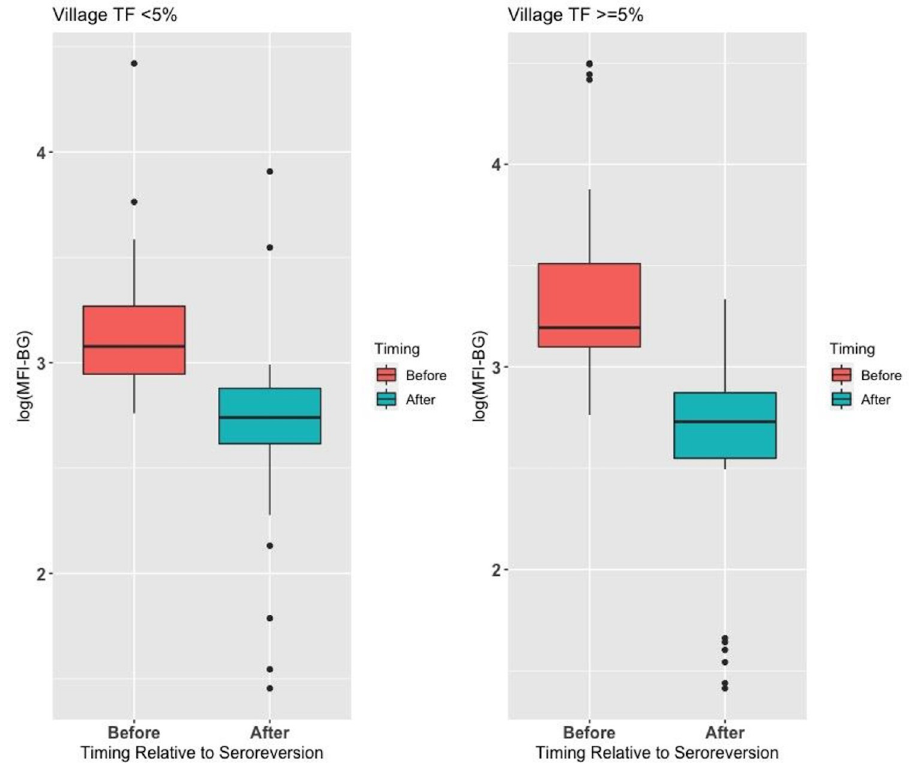
Fig 2. Log of MFI-BG in seroreverters in the survey immediately before and in the survey that defined seroreversion.